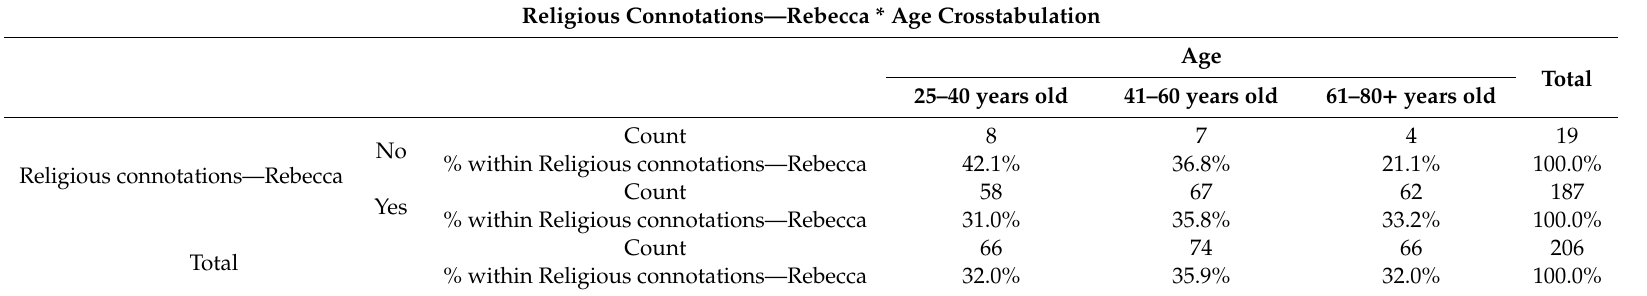
Table 5. Religious connotations in terms of age for the name Rebecca in the metropolitan district of